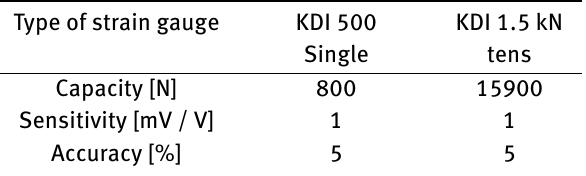
Table 2: Strain gauge sensor parameters Type of strain gauge